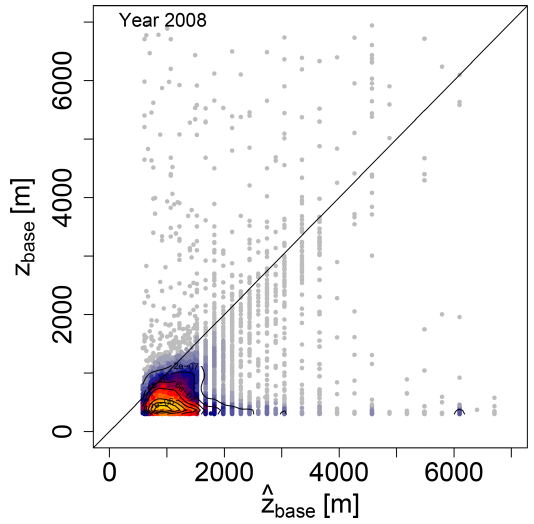
Figure A1. Joint density of z base and ˆ z base for the year 2008 ap- plying a lower threshold height h min = 300m + H + 2 σ h (Eq. A1) for the distinction between surface and cloud pixels in contrast to Eq.